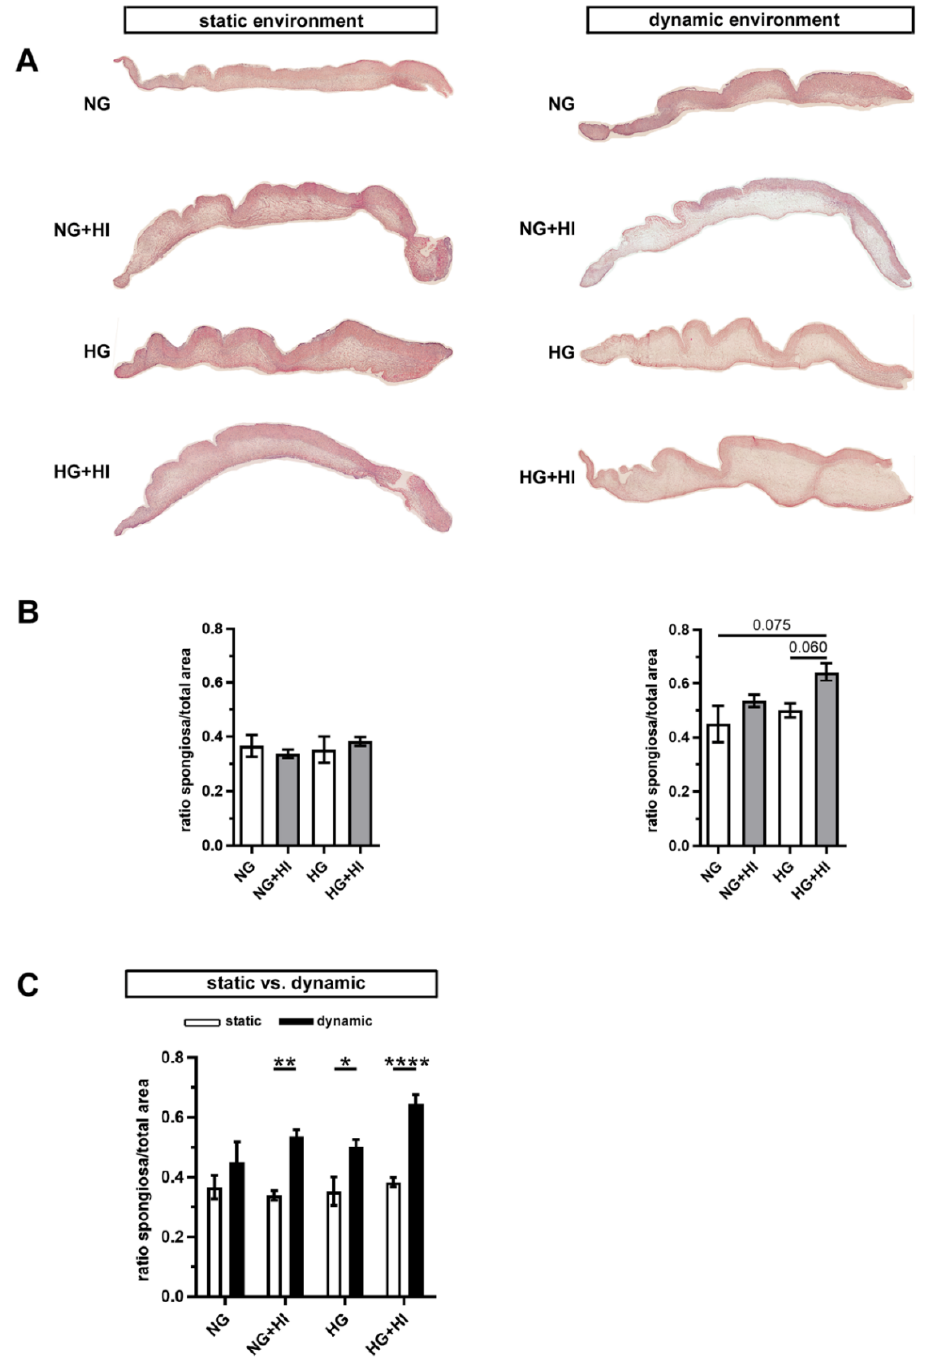
Figure 4. AV tissue remodeling. ( A ) Representative images of H&E staining of the cultivated leaflets with the aortic side up and the free edge to the left. Typical tissue architecture was preserved in all AV specimens comprising the three layers of AV: lamina fibrosa, lamina spongiosa and lamina ventricularis. ( B ) The ratio of lamina spongiosa area with respect to total leaflet area was calcu- lated from leaflet cross sections as an indicator of tissue remodeling in the spongiosa in response to different cultivation conditions. While static samples were unaffected by chronic HI and HG, samples of the bioreactor system showed a trend towards the thickening of the lamina spongiosa due to HI + HG treatment. n = 5–6 ( C ) Dynamic flow cultivation resulted in increased hypertrophy in the spongiosa as compared to the static environment, irrespective of the applied metabolic con- dition. n = 5–6; *: p < 0.05; **: p < 0.01; ****: p < 0.0001; NG: normoglycemia; HI: hyperinsulinemia; HG: